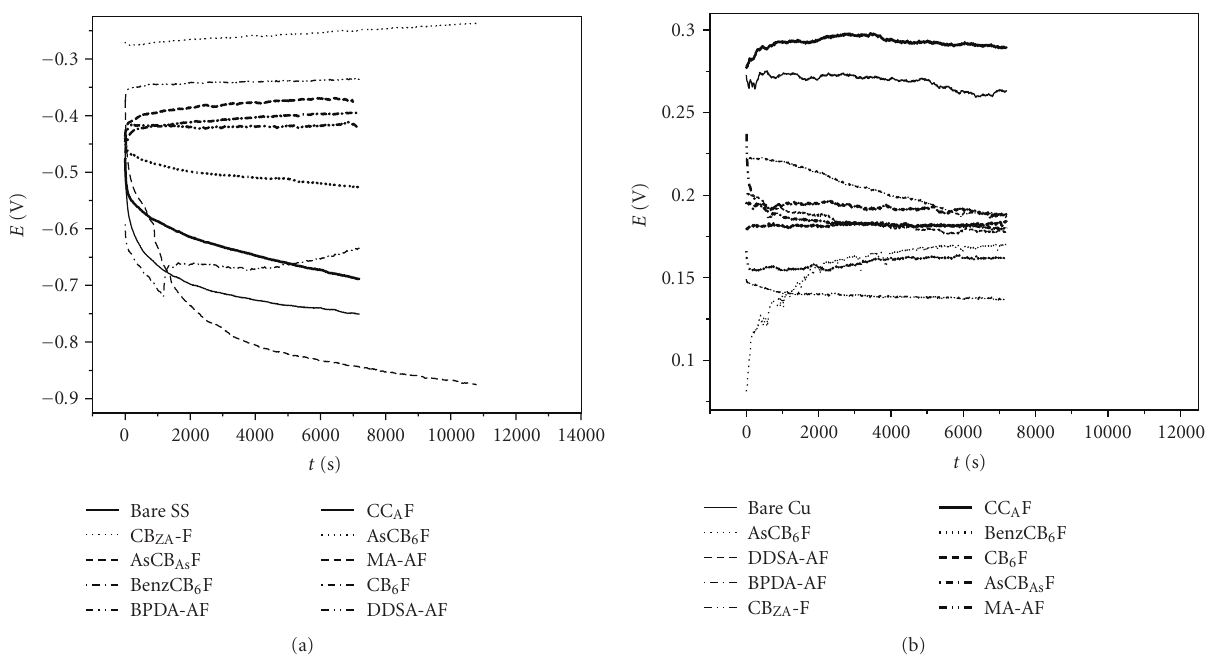
Figure 2: Variation of the open circuit potential versus time of bare and resin coated SS (a) in copper; (b) in 1 N H 2 SO 4 .